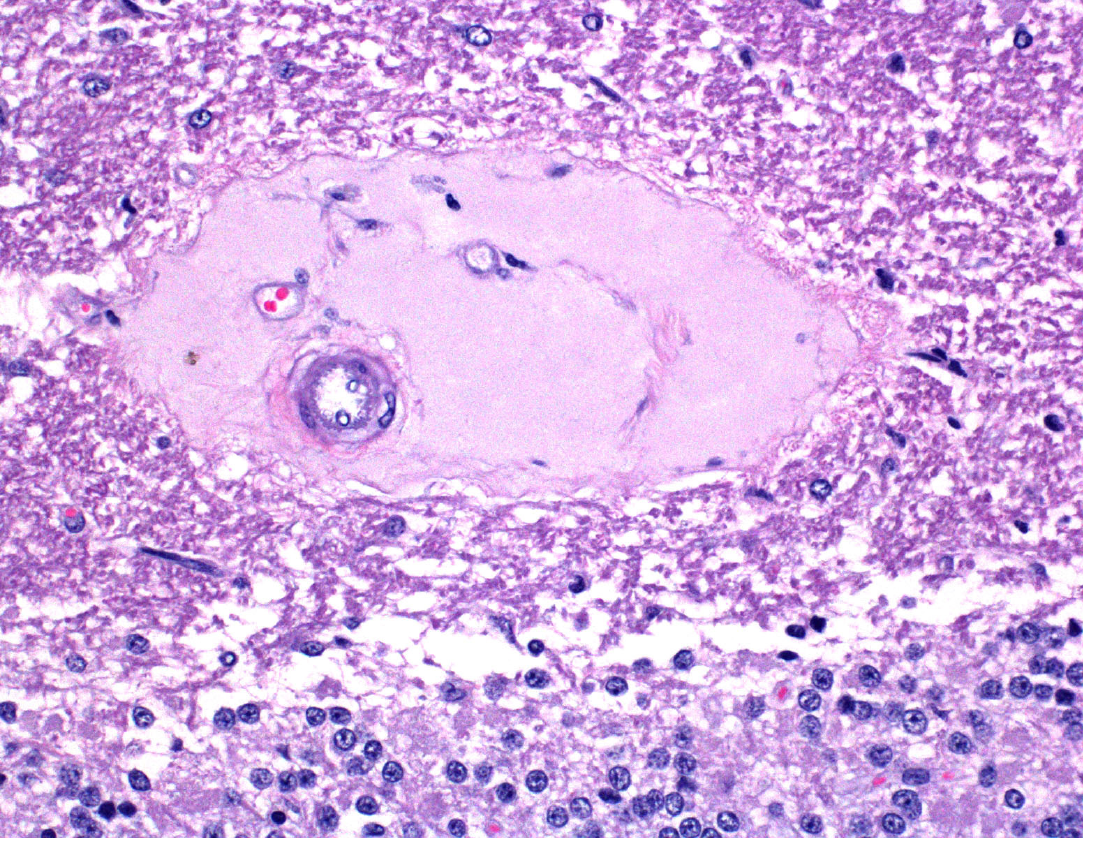
Figure 3. Microangiopathy with perivascular deposition of extravasated protein-rich fluid in acute ovine ETX intoxication. H&E.